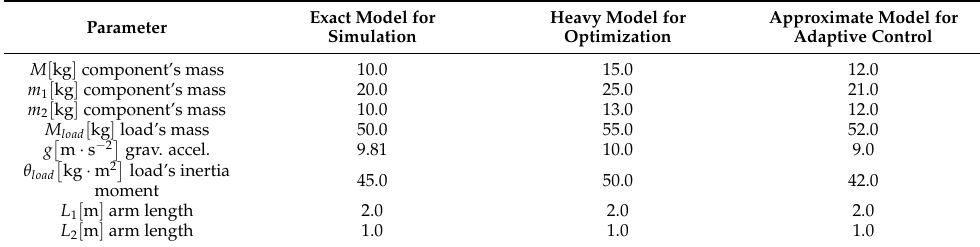
Table 1. The Dynamic Model Parameters in Equations (4)–(7).